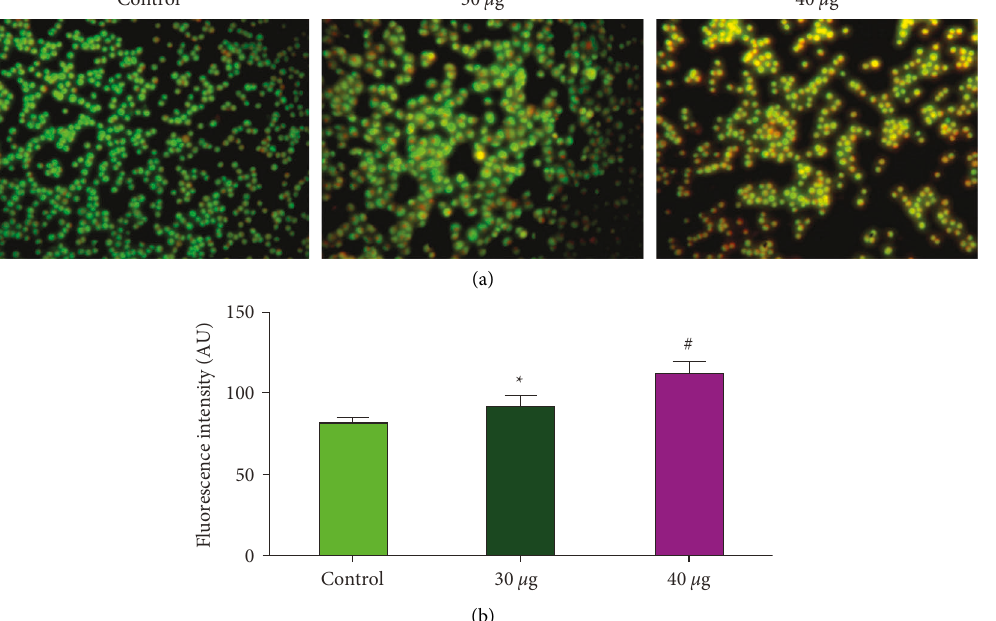
Figure 7: Apoptotic effect of CTCANc in the blood cancer MOLT4 cells. We used AO and EtBr (1:1) to color control and treated cells with nanocomposites (30 and 40 μ g /ml, 24hr), and statistical significance was calculated as ∗ p < 0 . 05 and # p < 0 . 001 based on a comparison with